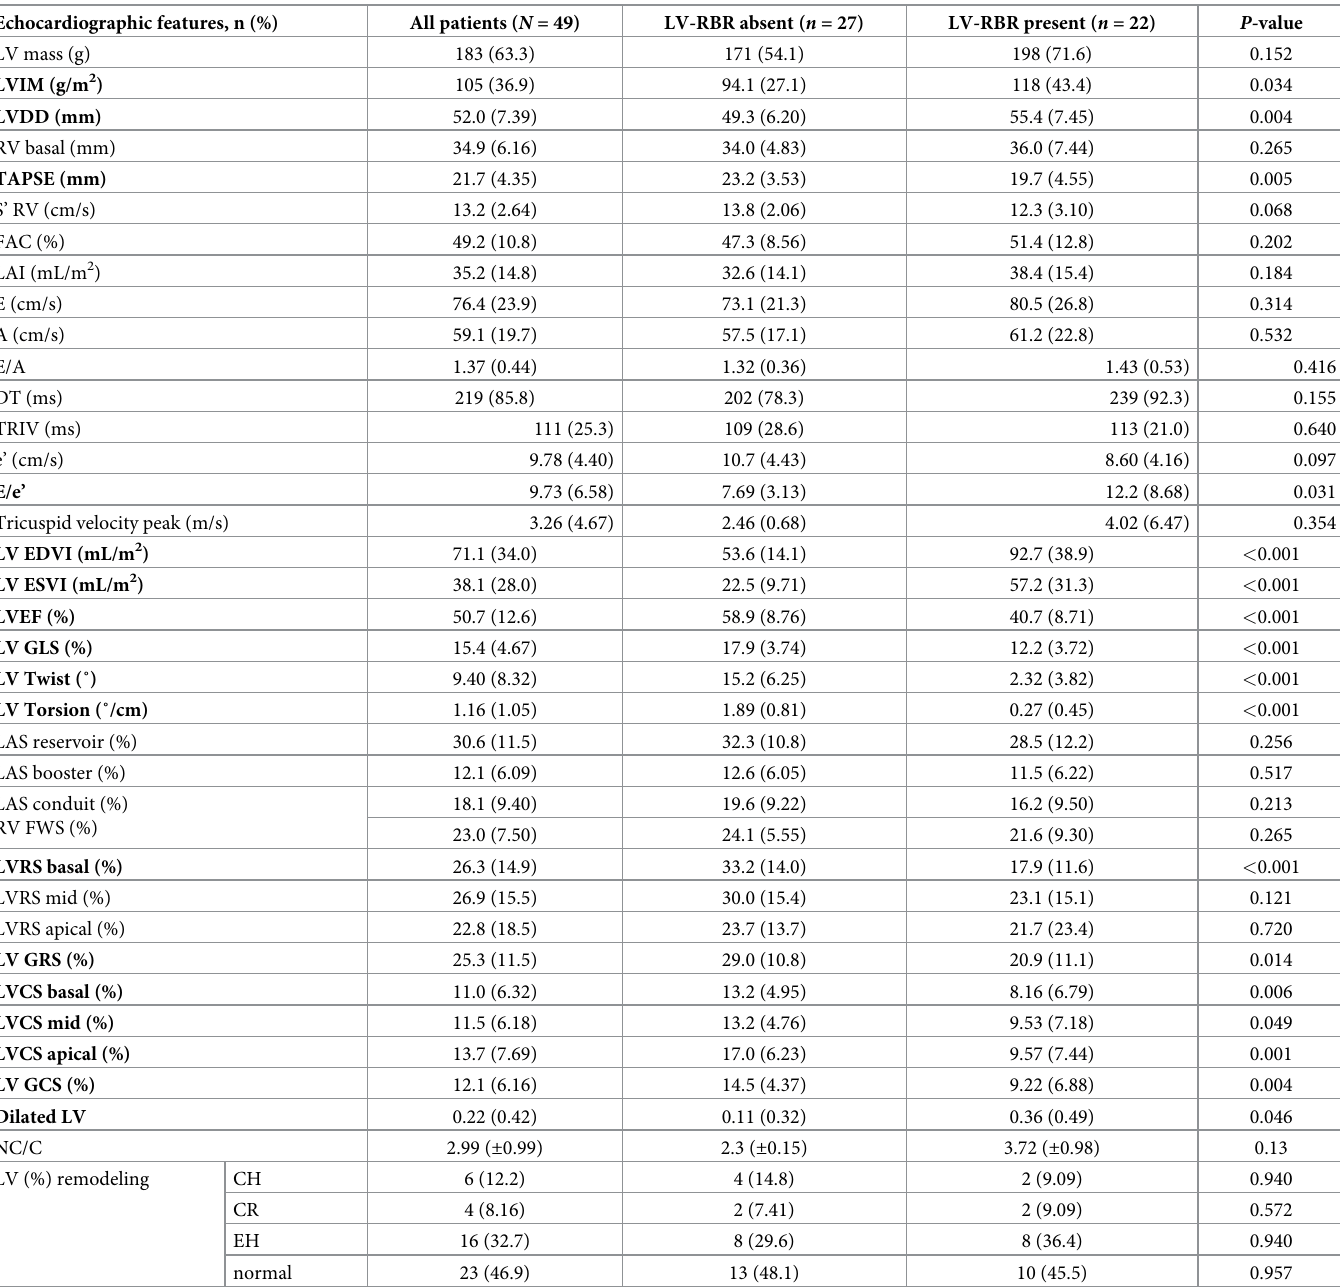
Table 2. Echocardiographic parameters evaluated in noncompaction cardiomyopathy with rigid body rotation and included in the prediction model. Echocardiographic features, n